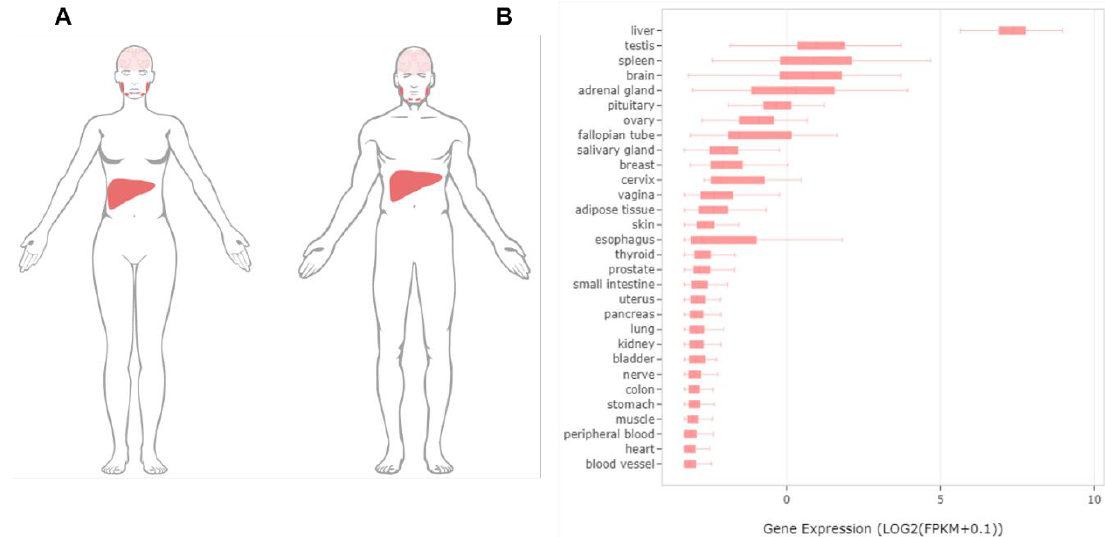
Figure 2. The distribution patterns of SLC13A5 in humans. ( A ) The global expression profiles of PXR in the human body (data available from https://www.proteinatlas.org/ENSG00000141485-SLC13A5/tissue#cbox, accessed on 14 July 2021). ( B ) The expression levels of SLC13A5 in different human tissues (generated via an Ingenuity Pathway Analysis (IPA); QI-AGEN).